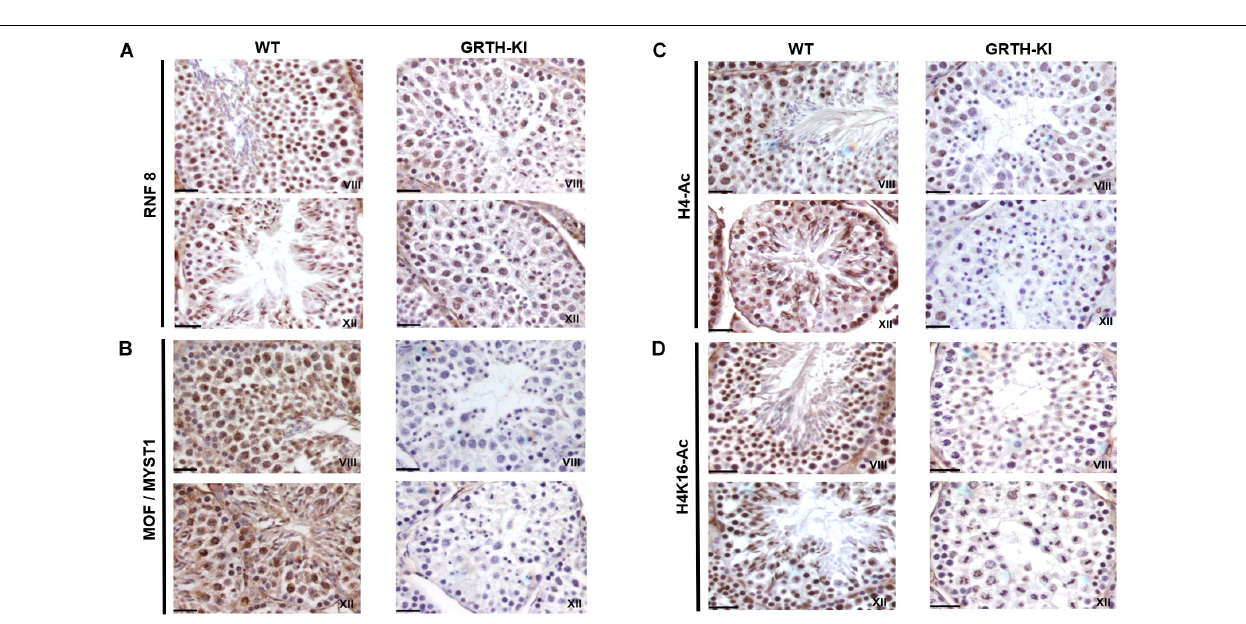
FIGURE 6 | IHC analysis of UBE2J1 in seminiferous tubules of WT and KI mice. UBE2J1 expression is localized (DAB signal) specifically in ES of stage X, XII, XIII of spermatogenesis. The signal intensity was gradually increased from stage X to XIII in WT.